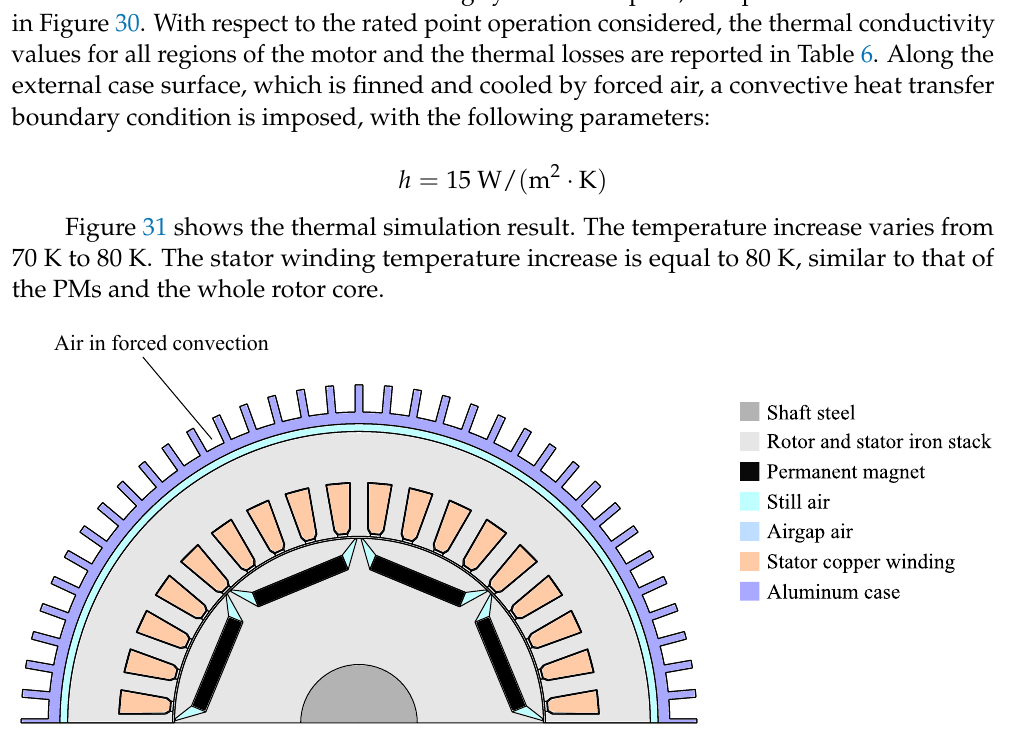
Figure 30. Motor model for the thermal finite element simulation of the IPM motor with a forced-air cooling